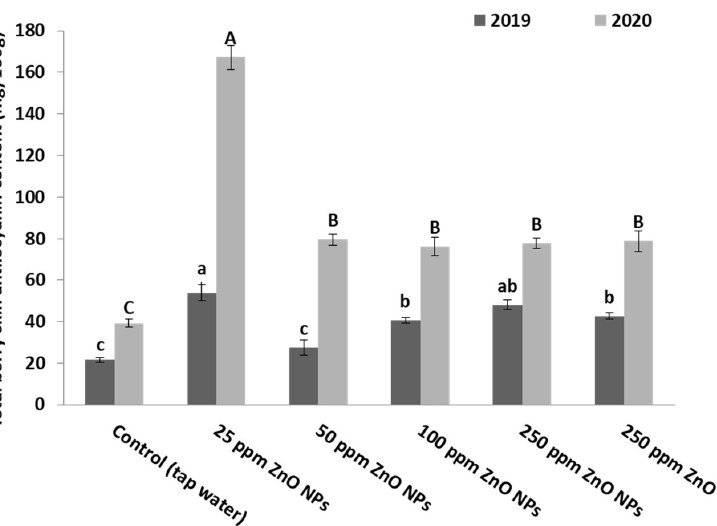
Figure 3. Effect of foliar spraying of ZnO NPs on the total anthocyanin content in the berry skin of Crimson seedless grape cultivar during two seasons: 2019 and 2020. Different letters indicate the differences based on Duncan’s multiple range test.